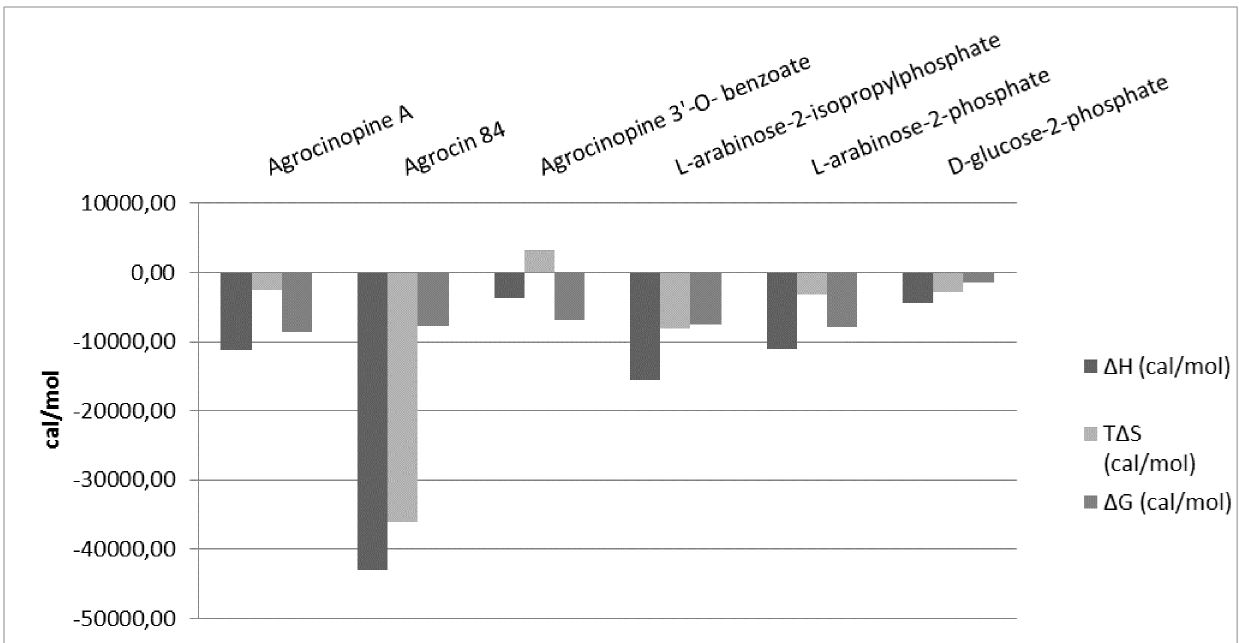
Fig 5. Comparison of microcalorimetry derived enthalpy ( Δ H, deep grey), entropic contribution (T Δ S, grey) and free binding enthalpy ( Δ G, light grey) at 293°K for agrocinopine A, agrocin 84, agrocinopine 3 ’ - O -benzoate, L-arabinose-2-isopropylphosphate, L-arabinose-2-phosphate and D-